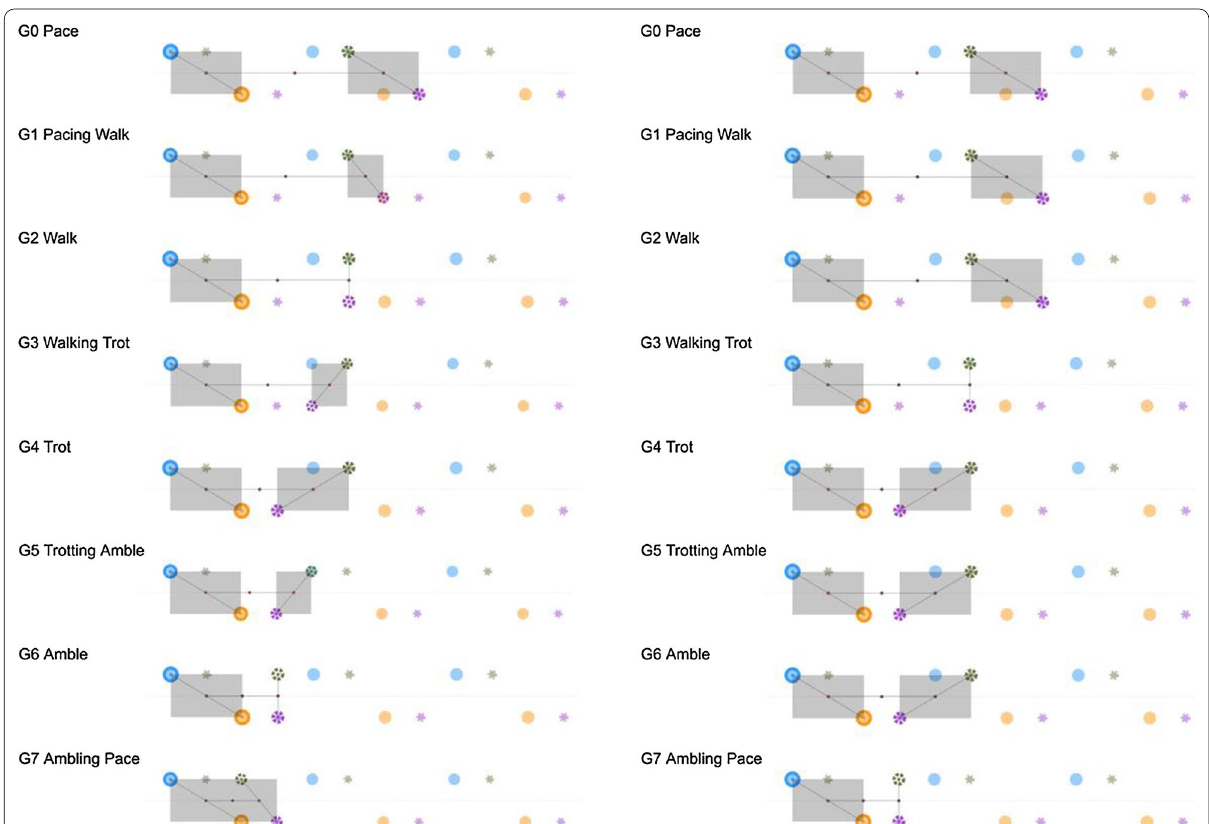
Fig. 6 Coupling length computations for the hypothetical regular trackway, for two choices of duty factor ( DF right) and the eight gaits ( G0 – G7 ). Each trial depicts the same point in a step cycle at which both hind limbs and the right forelimb are in support and the left pes is about to start transition. For the high duty factor trials (right column), note that G0 , G1 , and G2 are consistent with the same CL (and likewise G4 , G5 , and G6 would be consistent with a constant, but shorter, CL